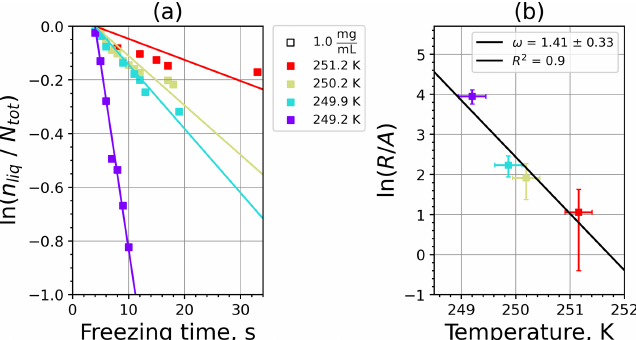
Figure A1. (a) The decrease in fraction of droplets which remained liquid with time at different temperatures in the isothermal experiments of fibrous cellulose (FC) at the M-WT. The colors correspond to different temperatures (particle concentrations of 1gL − 1 ). Typical error bars are depicted in Fig. 6. (b) Freezing rate of FC normalized to surface area as a function of temperature.